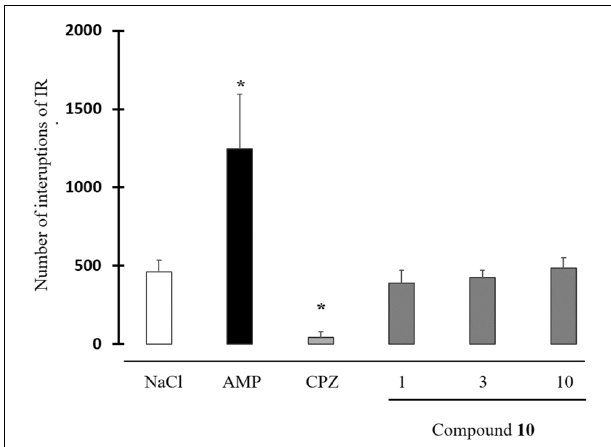
FIGURE 5 | Effect of compound 10 on spontaneous locomotor activity. Data are expressed as the mean ± standard deviation ( n = 8). Drugs were administered intraperitoneally (IP) 30 min before the behavioral test. Compound 10 : 1–3–10 mg/kg; AMP: amphetamine 2 mg/kg; CPZ: